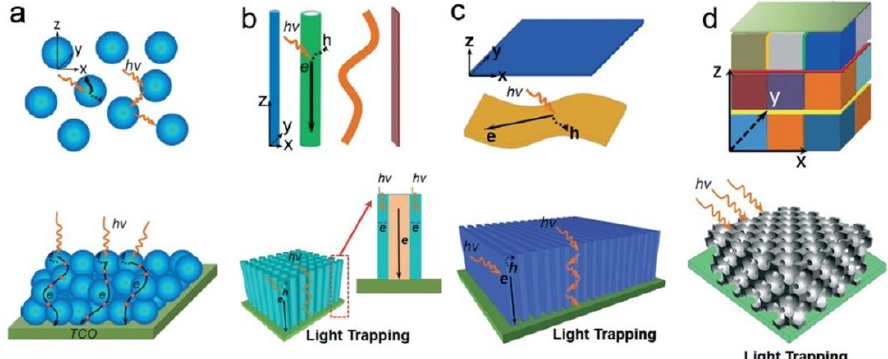
Figure 3. Various nanoscale architectures that can be used in photocatalytic applications from ( a ) 0D nanocrystals, ( b ) 1D nanostructures, ( c ) 2D nanosheets and films, and ( d ) 0D-1D-2D integrated 3D nanostructures. The figure also illustrates the light scattering, light trapping, and charge transport processes in the corresponding nanostructures. Reprinted with permission from Ref [9] Copyright 2015 Royal Society of Chemistry. Figure 3d originally adapted by Ref [9] from Ref [86] with permission from John Wiley, and reprinted here with permission from John Wiley. Copyright John Wiley and Sons (2013).